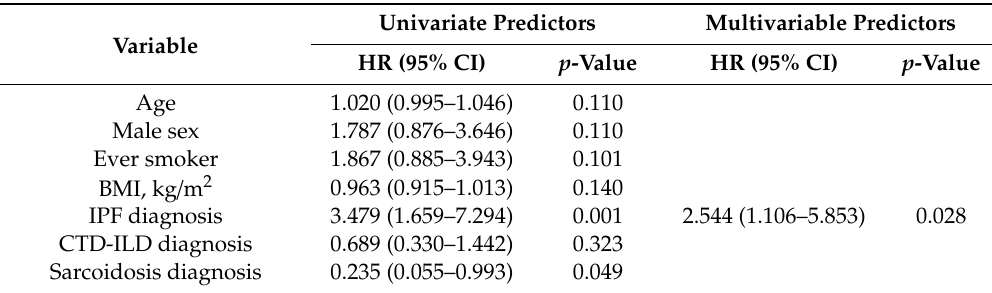
Table 5. Cox proportional hazards regression analysis showing predictors of mortality in patients with severe pulmonary hypertension ( n =